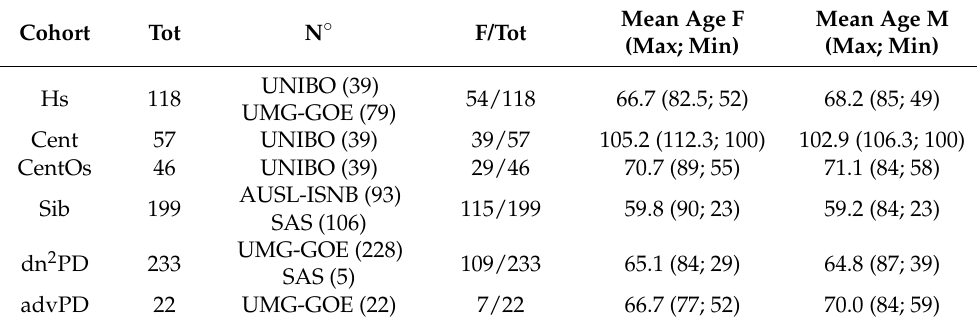
Table 1. Design and characteristics of the cohorts included in the study.